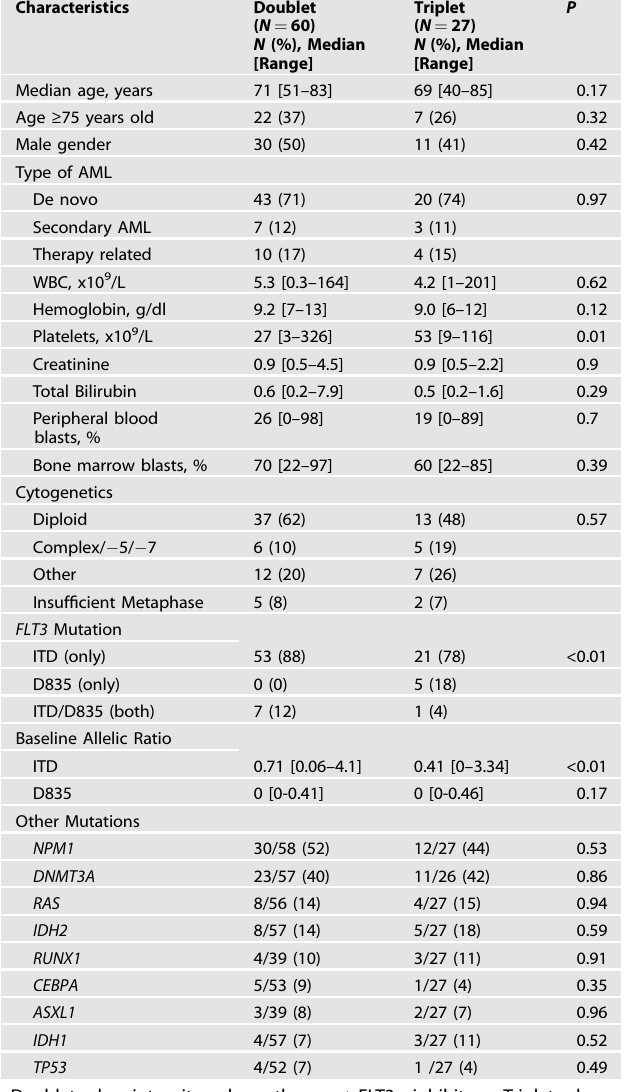
Table 1. Clinical characteristics of patients treated with doublet vs. triplet regimens.